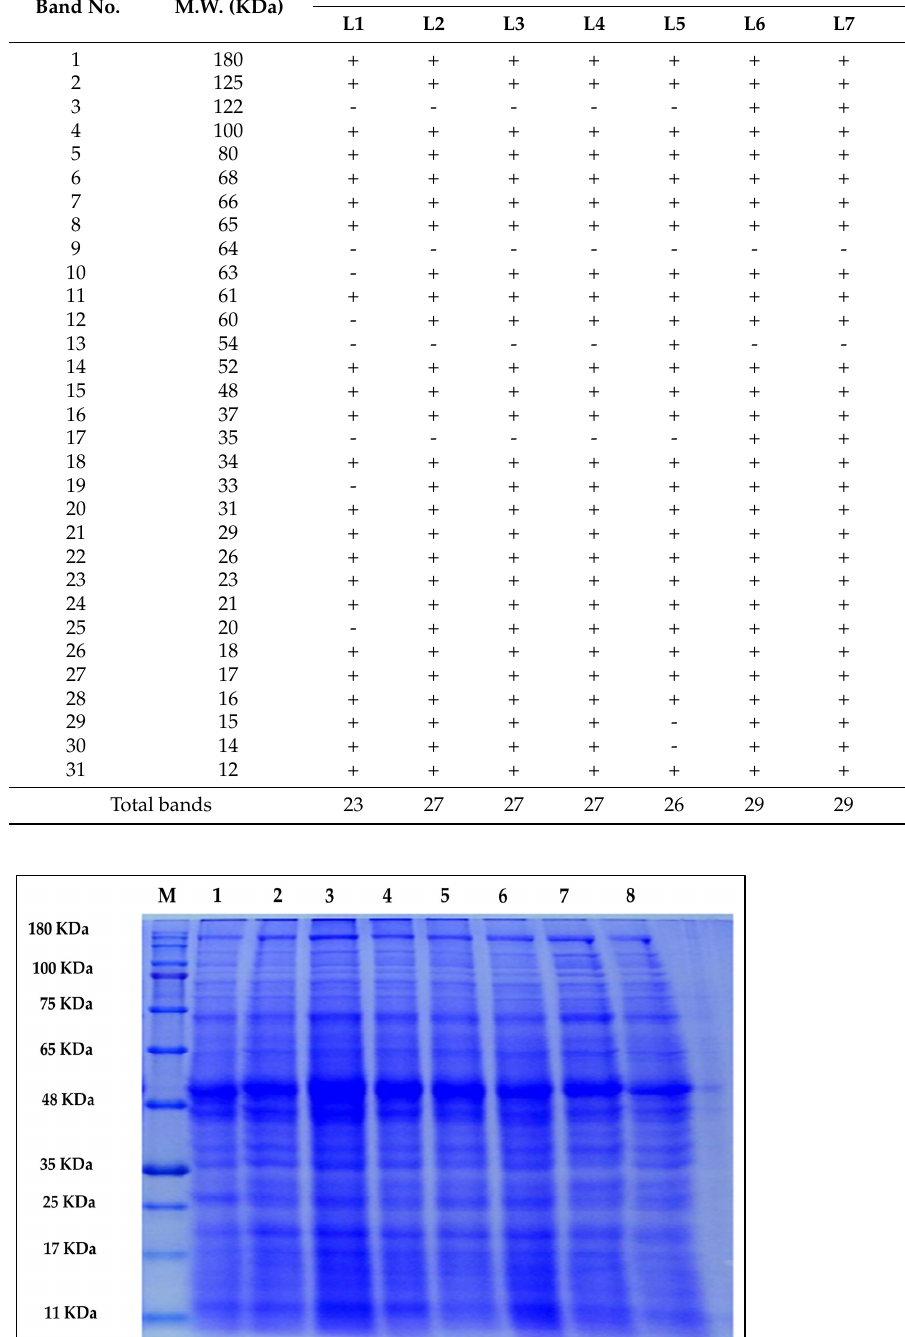
Figure 4. Effect of arginine pre-treatments on protein profile in flag leaves of wheat plants grown under drought stress. L1: normal control, L2: arginine 0.25 mM, L3: arginine 0.5 mM, L4: arginine 1 mM, L5: drought stress, L6: drought stress + arginine 0.25 mM, L7: drought stress + arginine 0.5 mM, L8: drought stress + arginine 1 mM.